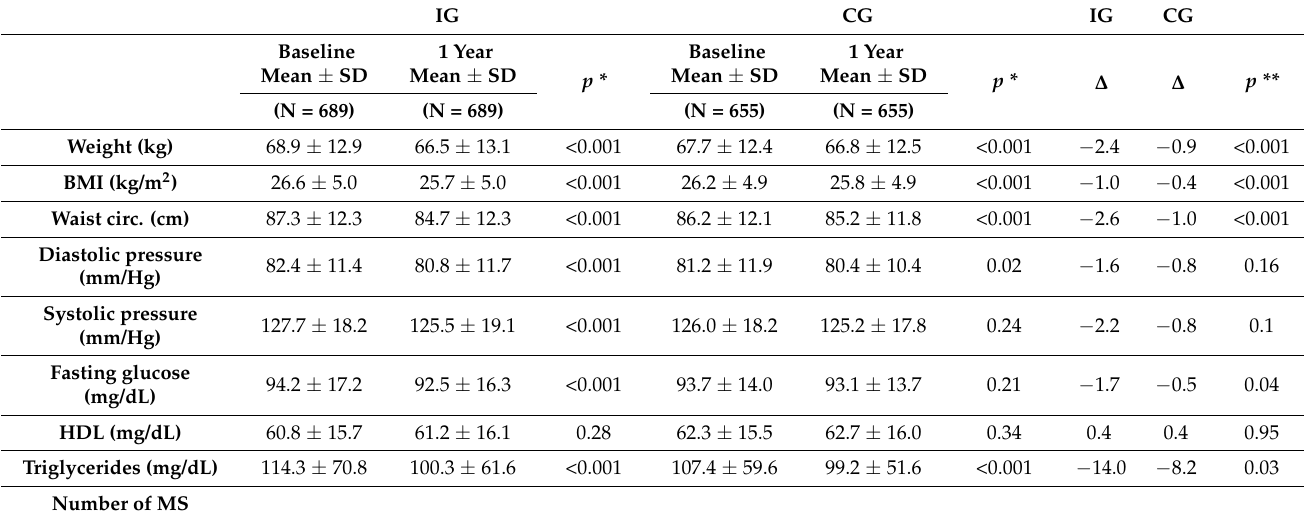
Figure 1. Baseline daily frequency of consumption of recommended and discouraged food by randomization group. The baseline distribution of frequencies of food consumption in the intervention group and in the control group is represented by a Kiviat diagram. This graphic representation consists of a sequence of rays that originate from a center and forms equal angles to each other; each ray represents one of the food/food group variables. The distance from the central point marked on the radius is the maximum achieved frequency of consumption (time/day). The points on the rays are joined with two segments which are red and continuous for the intervention group and dashed for the control group. Table 2. Changes of anthropometric and metabolic parameters by randomization